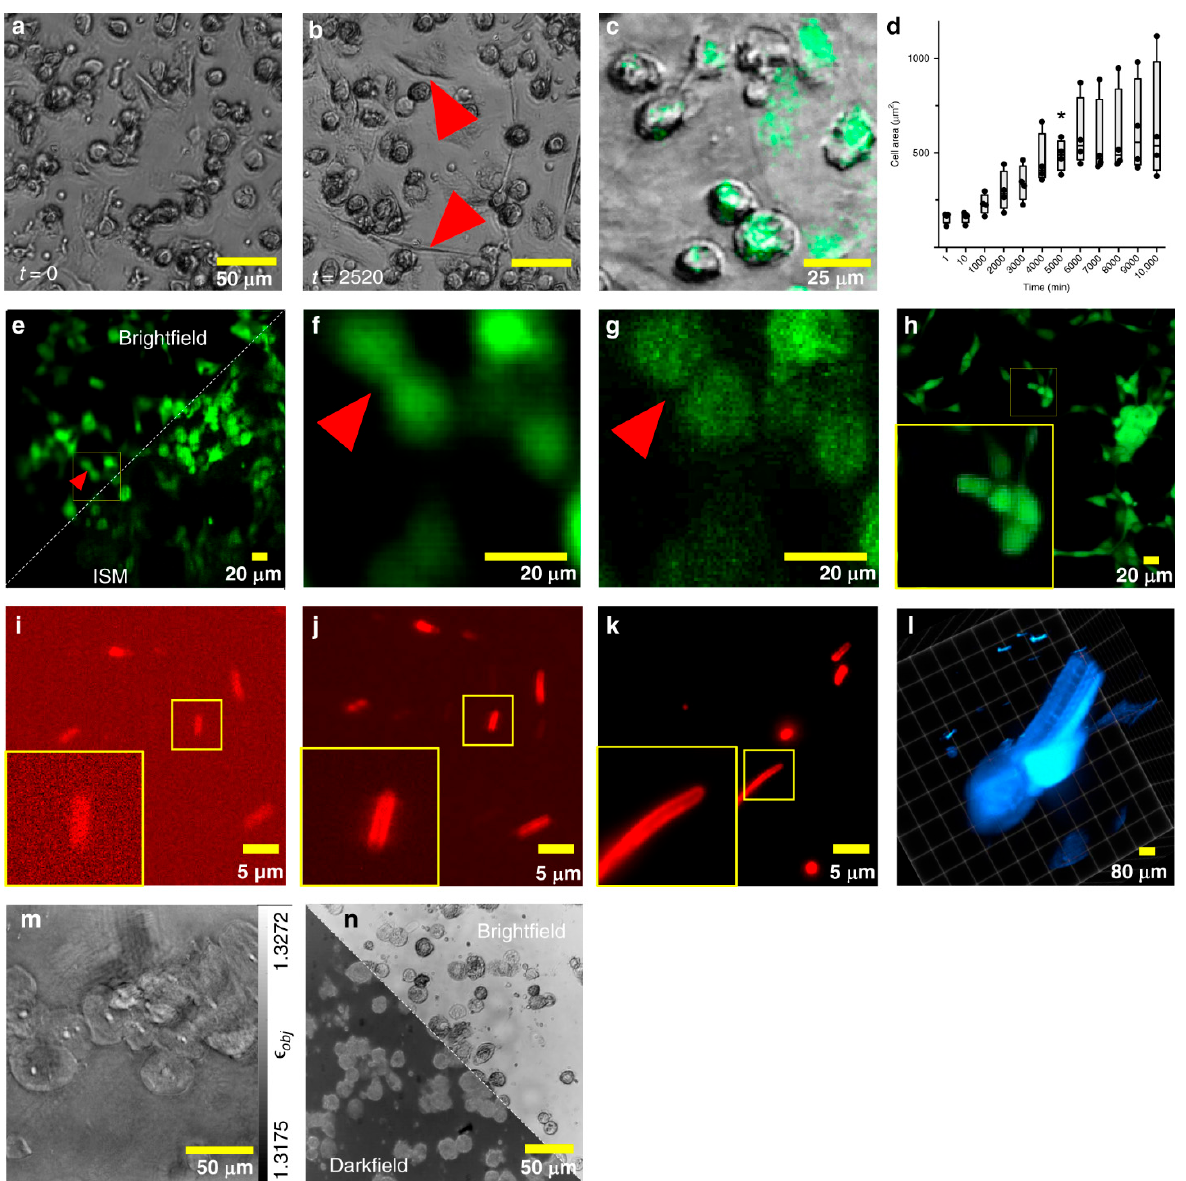
Figure 11. Diedrich et al. demonstrated the ability to continuously monitor morphological changes in macrophages with a smartphone camera, shown in panels ( a – c ). Panel ( d ) represents the growth of the differentiating cells at various time points where panels ( e – n ) represent various other types of images taken of the cells throughout this study. Reproduced from [116] under Creative Commons Attribution 4.0 License.